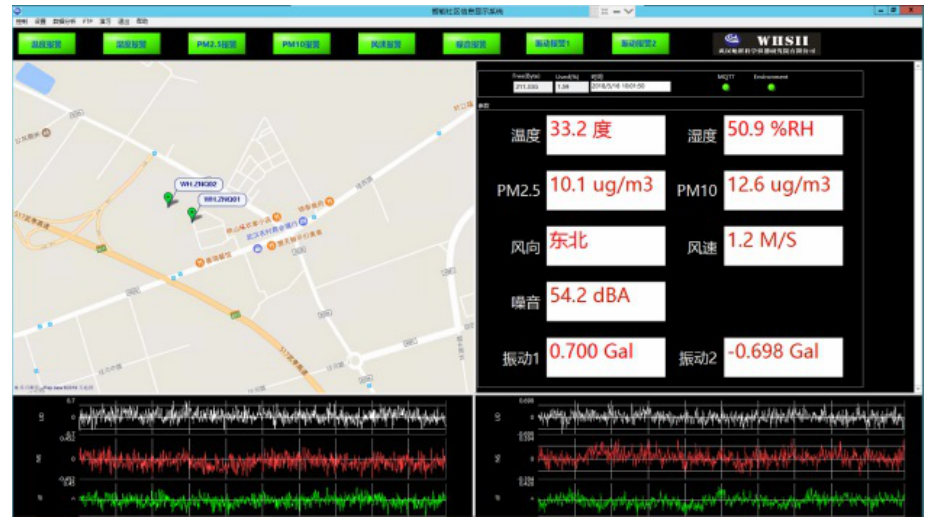
Fig. 4 Main interface of Xinheyuan Smart Community